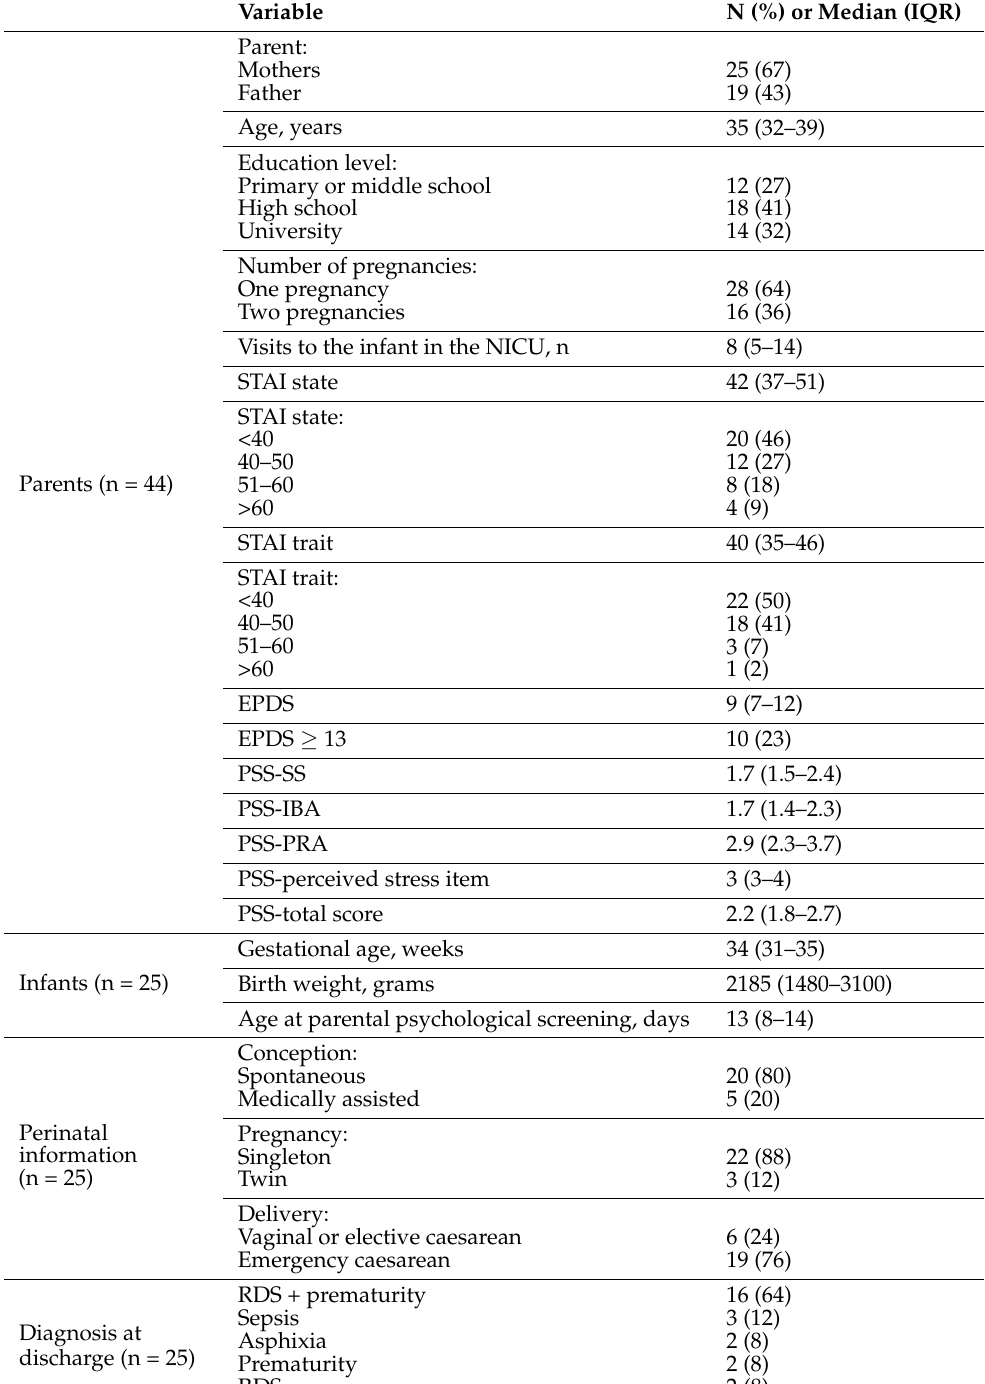
Table 1. Parental and neonatal